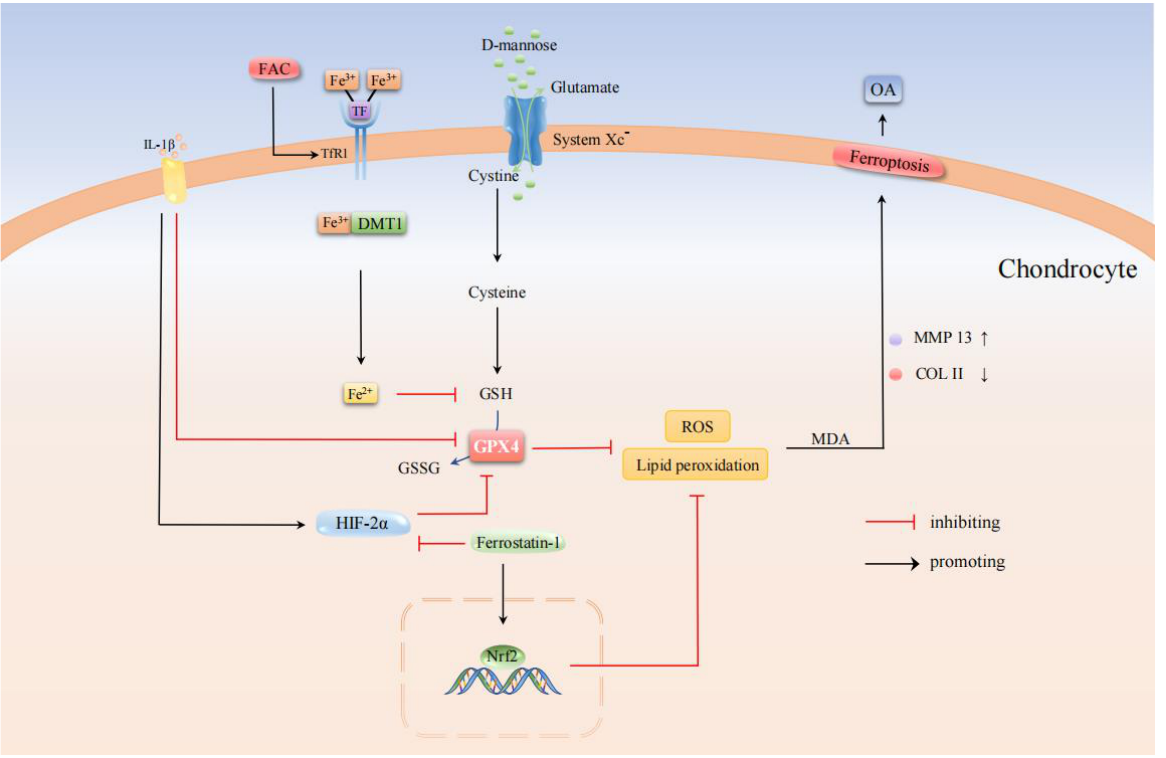
Figure 4. Molecular pathways in the regulation of osteoarthritis by ferroptosis. Ferrostatin-1 inhibited chondrocyte ferroptosis and slowed down the development of OA in mice by increasing the expression of collagen type II and GPX4. D-mannose reduces the sensitivity of chondrocytes to ferroptosis by increasing HIF- 2α -mediated RNA and protein levels of GPX4 and SLC7A11.